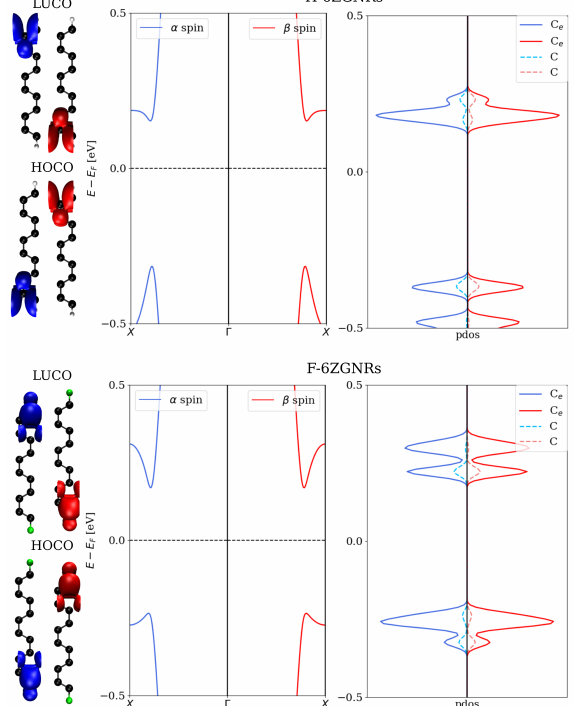
Figure 3. Bandstructures and projected density of states (PDOS) on two different groups of carbon atoms (C e denotes edge ones, while C denotes the others) of H-6ZGNRs and F-6ZGNRs are shown. The lowest unoccupied crystal orbitals (LUCO) and highest occupied crystal orbitals (HOCO) for each structures are illustrated. The α and β spin channels are presented in red and in blue,